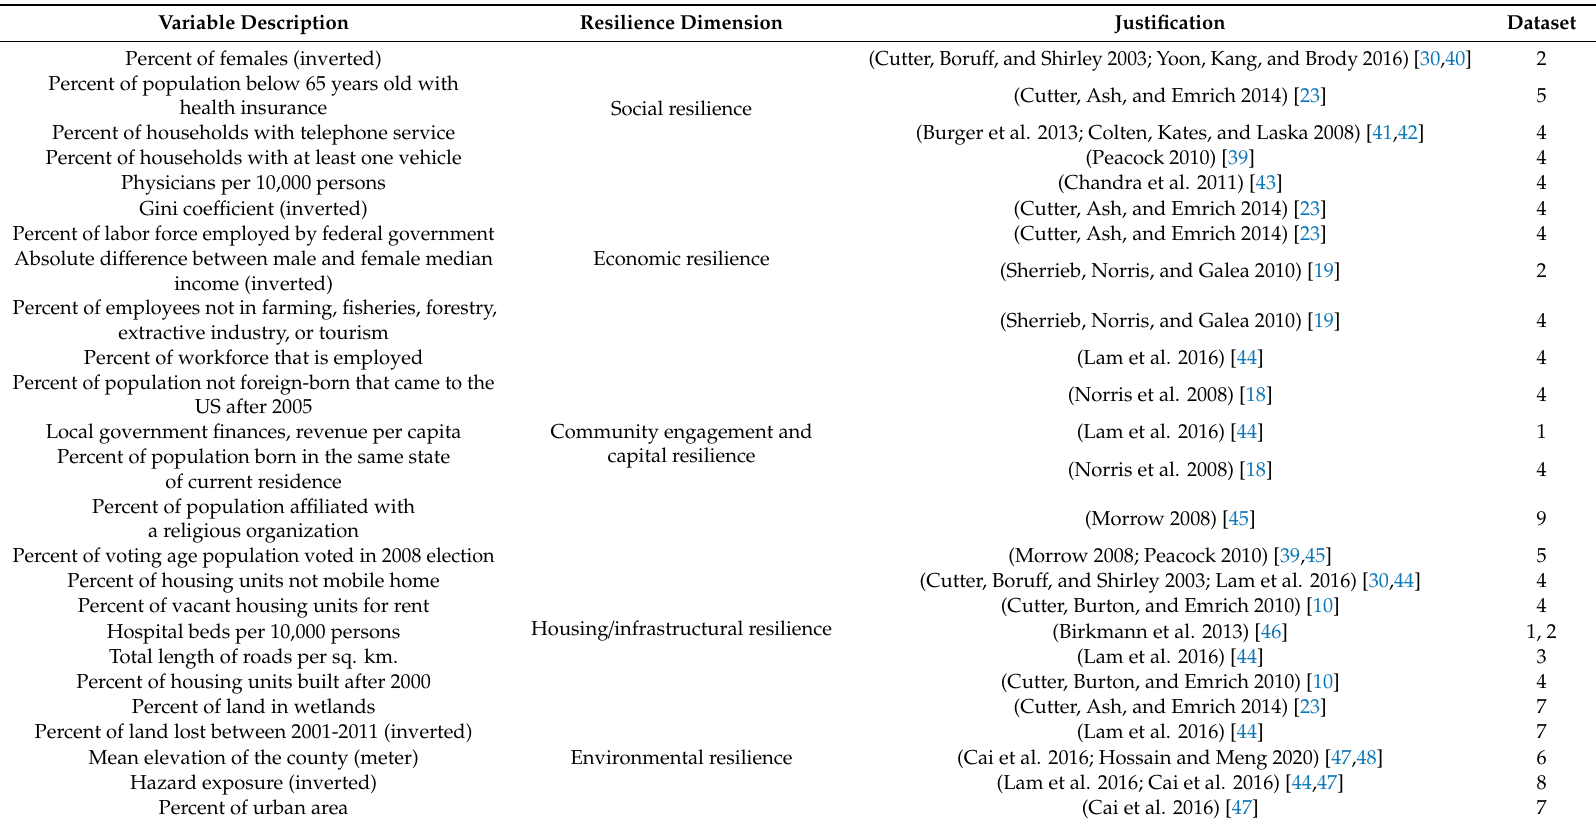
Table 2. Resilience variables with description and justification. Dataset numbers correspond to the numbers in Table